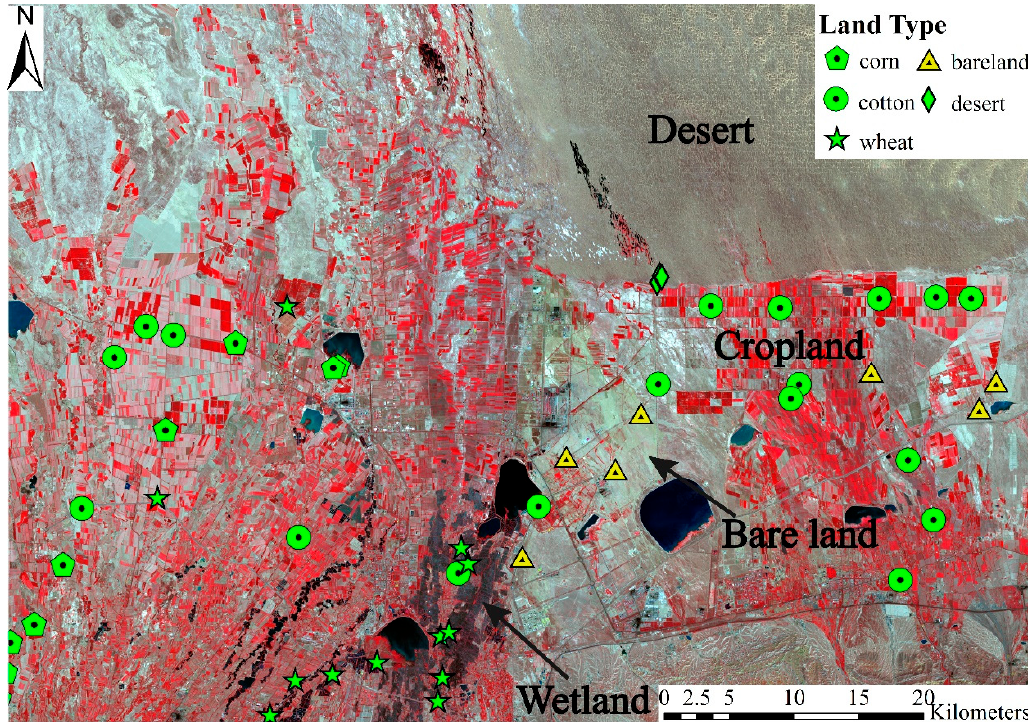
Figure 2. The positions of the fifty-one soil moisture samples with different land cover types in the surrounding areas of the Fukang City. Typical land cover types, such as desert, farmland, bare land, wetlands, are marked with text in the map.